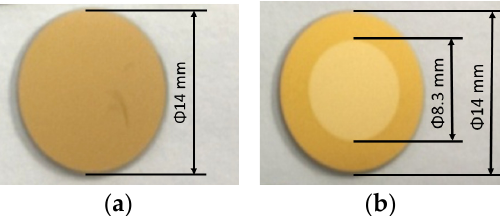
Figure 10. QCM sensors for measurement: ( a ) QCM sensor coated with carbon films; ( b ) QCM sensor after carbon removal in the center.